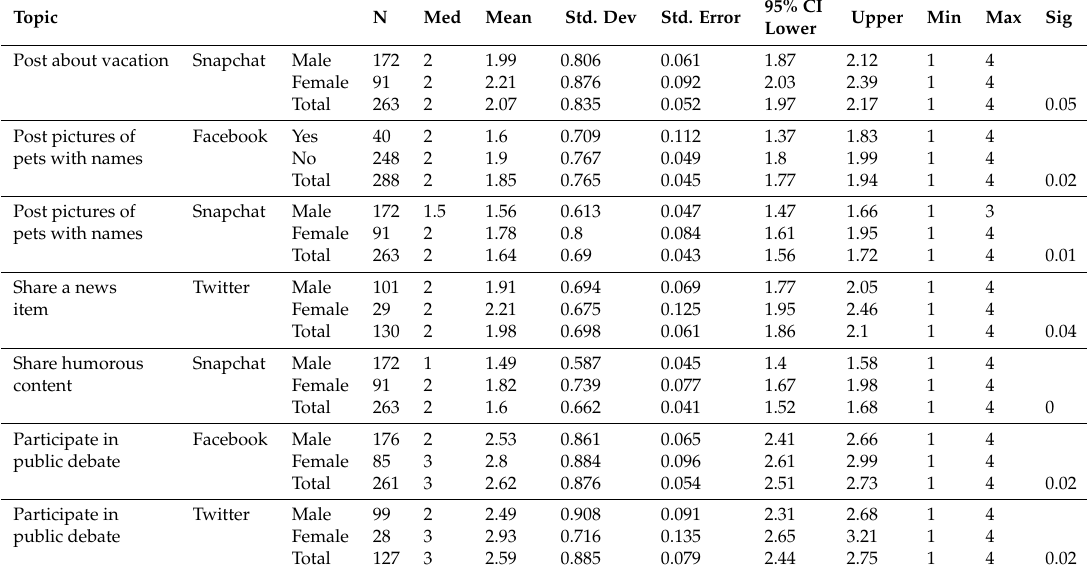
Table 18. Differences in risk perceptions between groups on “How do you perceive risk when you conduct the following action on